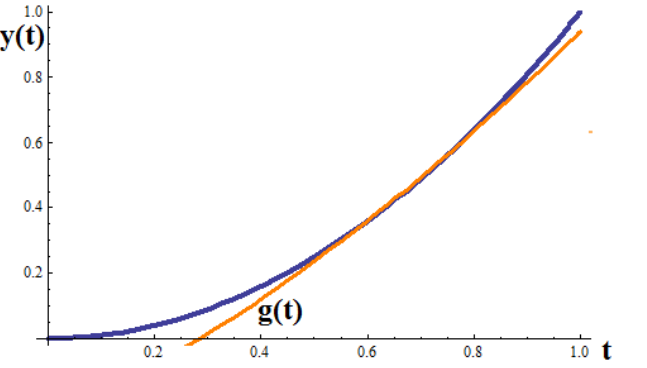
Figure 4. The curve y(t) and the fractional tangent space in the initial space at the point t = 0.81 and γ = 0.6